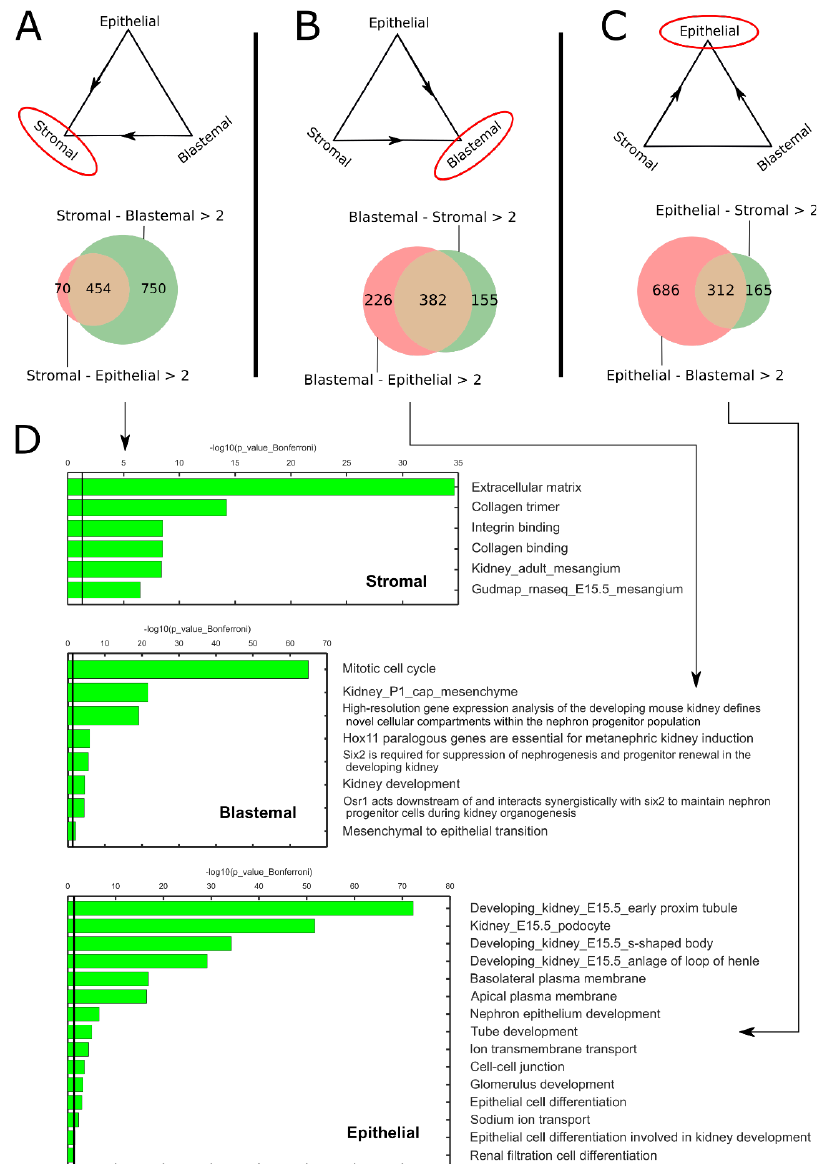
Figure 2. GO enrichment analysis shows that the stromal, blastemal, and epithelial archetypes are enriched for genes that are characteristic of the un-induced mesenchyme, the cap mesenchyme, and renal epithelium of the fetal developing kidney, respectively. ( A – C ) For each of the three archetypes, we selected a set of genes for which the log2-fold change was larger than two, with respect to the other two archetypes. These genes were used as input to Toppgene. ( D ) It can be seen that the stromal archetype over-expresses genes that are characteristic of the un-induced mesenchyme, for example, genes responsible for creating and maintaining the extracellular matrix. The blastemal archetype over-expresses genes that are characteristic of the cap-mesenchyme; for example, genes responsible for maintaining nephron progenitors and for the mesenchymal to epithelial transition (MET). Likewise, the epithelial archetype over-expresses genes that are characteristic of the fetal renal epithelium; for example, genes responsible for nephron epithelial differentiation and genes responsible for creation and maintenance of renal proximal tubules, S-shaped bodies, cell – cell junctions, and membrane transporters.